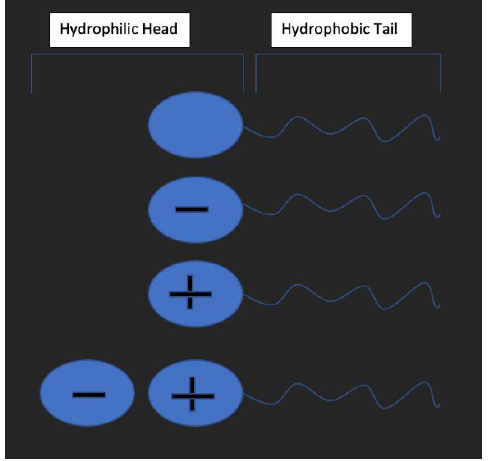
Figure 6. Types of surfactants according to charge.